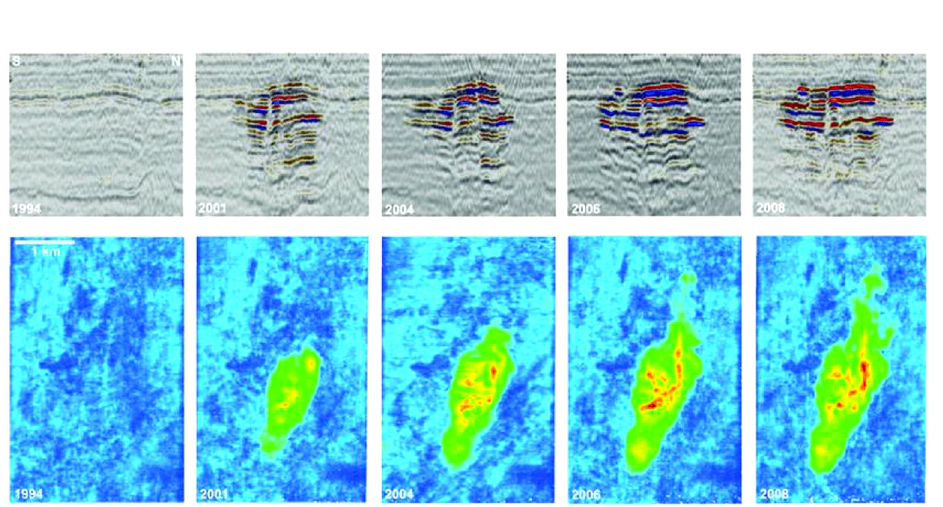
Fig. 18. – A spectacular example of 4D seismic from the Sleipner CO 2 storage field (Norway). From left to right the baseline survey and periodic monitoring survey are shown, documenting the evolution of the CO 2 plume over the years in cross-section (top) and plane view (bottom)